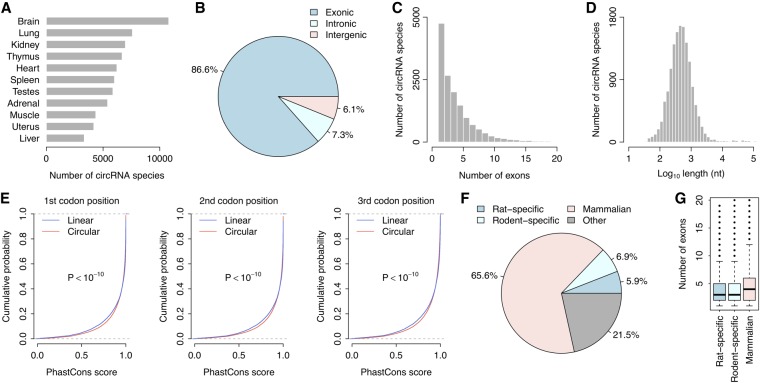
The rat circRNA repertoire. (A) Comparison of the number of circRNA species across the 11 rat tissues. (B) Fractions of exonic, intronic, and intergenic circRNA species within the repertoire. (C) Histogram of the number of exons in the exonic circRNAs of rats. (D) Histogram of circRNA length in rats. (E) Cumulative distribution of the PhastCons scores of both linear and circular transcripts at the three codon positions. A significantly increased PhastCons score was observed for the circular transcripts compared with the linear transcripts. The P-values were calculated with the Kolmogorov–Smirnov test. (F) Fractions of mammalian-common, rodent-specific, and rat-specific circRNA species within the repertoire. (G) Comparisons of exon numbers among the mammalian-common, rodent-specific, and rat-specific circRNAs.